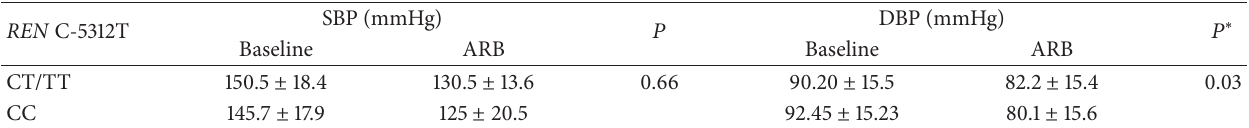
Table 5: Genetic variants of the REN and reduction in blood pressure (telmisartan therapy).